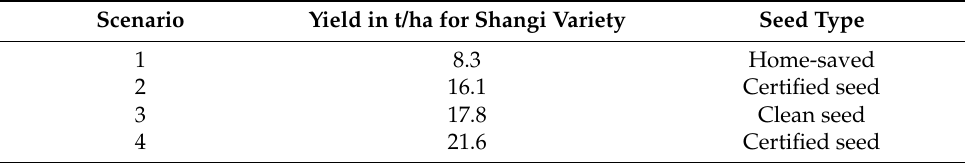
Table 6. Yield in t/ha per